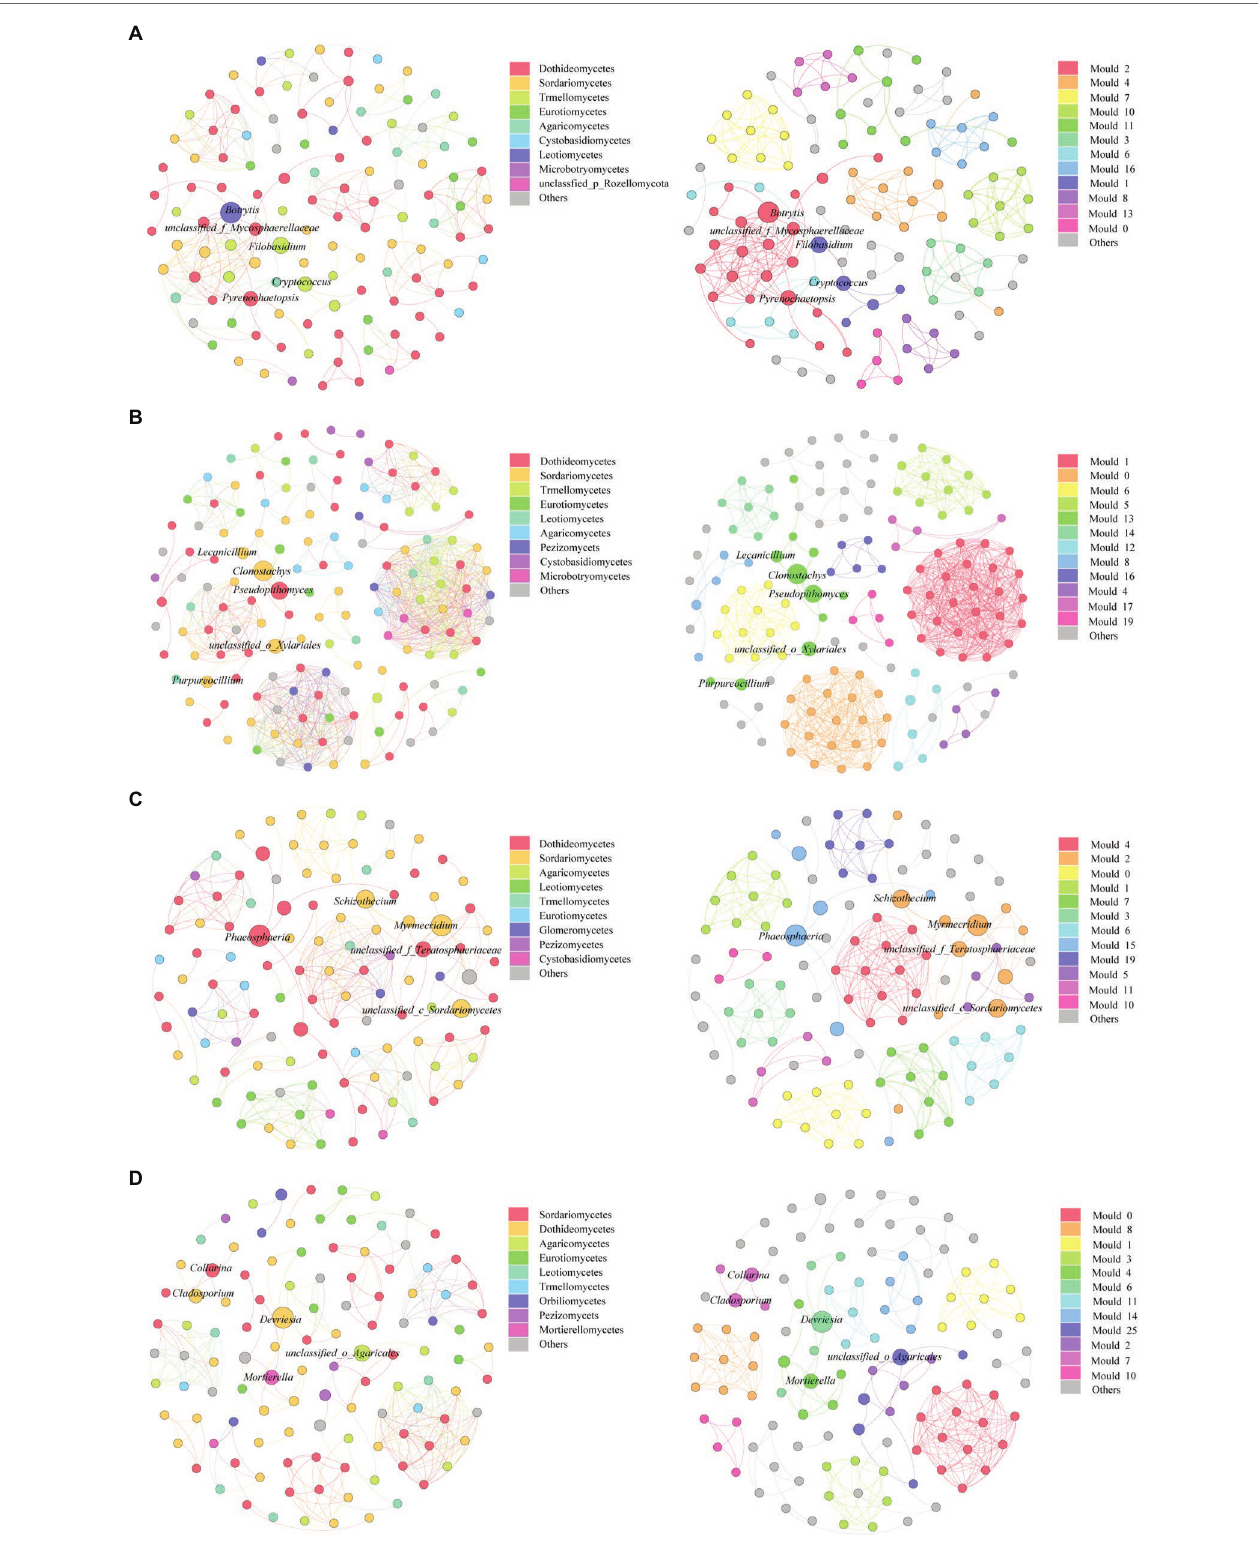
FIGURE 5 | Change of fungal community co-correlation network at D0 (A) , D100 (B) , D200 (C) , and D460 (D) . Each node represented a fungal genus, and the line represented a significant correlation between two genera ( p < 0.001). The nodes in the left figure of each decomposition stage were colored by class level, and the nodes in the right figure were colored by module. The top 10 litter fungal classes and modules were defined, and the other microbial were defined as